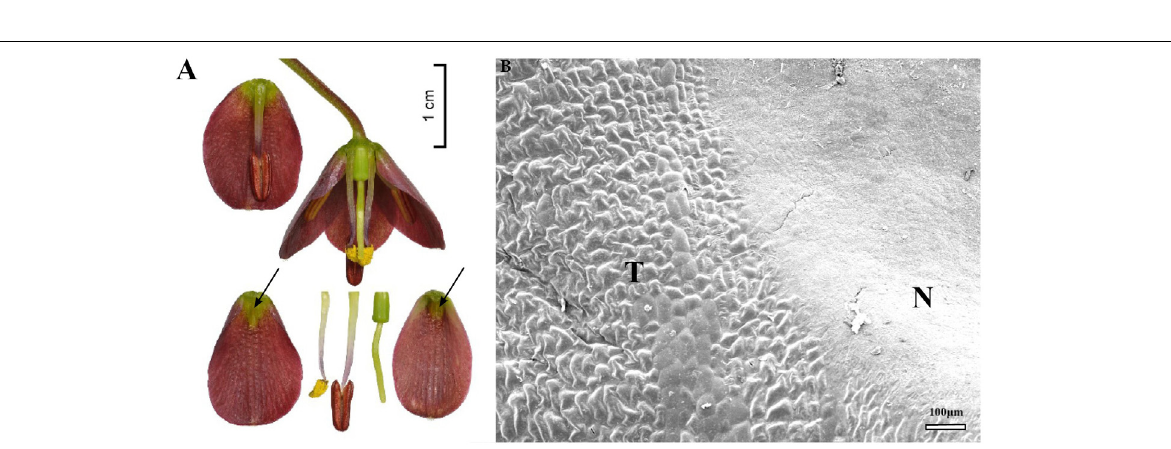
FIGURE 12 | Flowers and nectaries of F. persica . Macro and SEM images. (A) Flowers and tepals, nectaries marked with arrows. (B) Part of outer tepal showing the flat nectary area (N) and slightly convex cells of surrounding area (T).